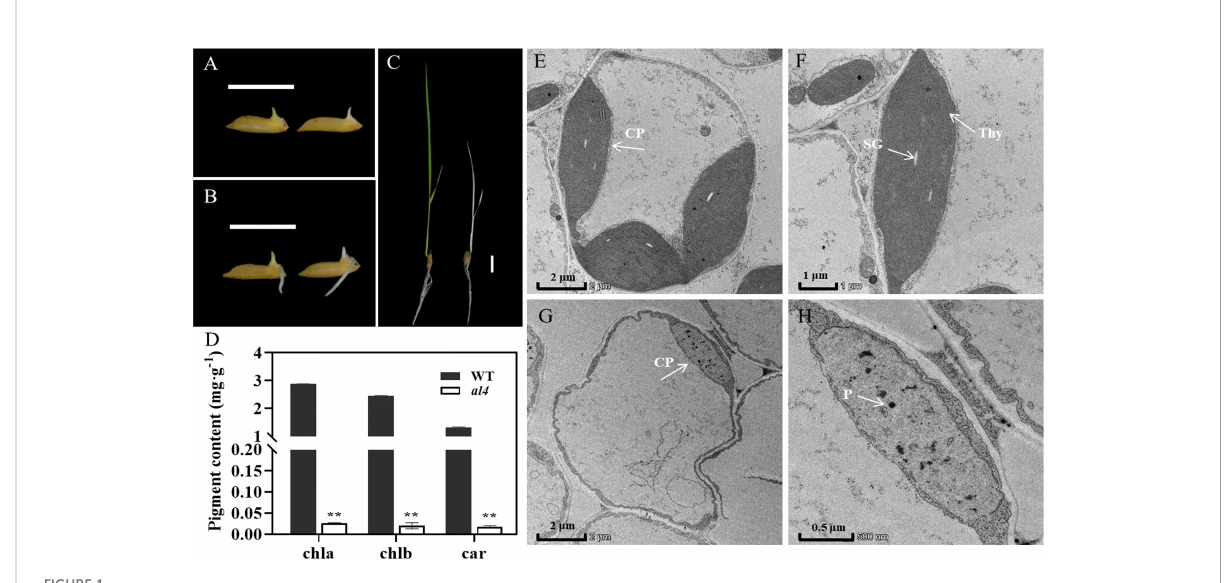
FIGURE 1 Phenotypic analysis of the albino leaf 4 ( al4 ) mutant. (A – C) Phenotypic comparison of WT (RH2B, left) and al4 mutant (right) at 2 day (A) , 3 day (B) and 10 day (C) after germination (DAP). Bars=1 cm. (D) Chlorophyll (Chla, Chlb) and carotenoid (Car) levels between WT and al4 mutant at 18 DAP. Data are presented as mean ± SD from three biological replicates. Two asterisks indicate statistically signi fi cant differences compared with the wild type at P< 0.01. (E – H) Transmission electron microscopy analysis of the leaves in WT (E, F) and al4 mutant (G, H) at the three-leaf stage. CP, chloroplast; SG, starch granule; Thy, thylakoid lamellar; P, plastoglobuli. Bar=2 m m (E, G) , 1 m m (F) and 0.5 m m (H)